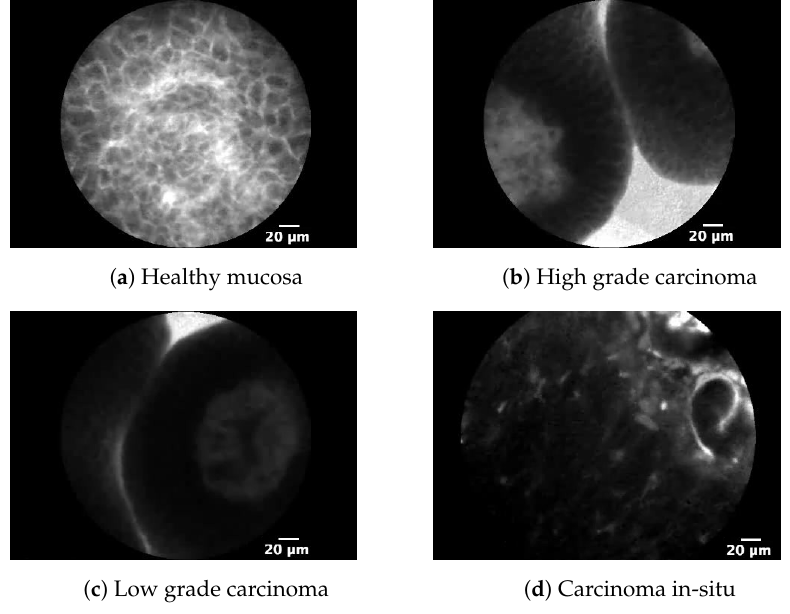
Figure 2. Representation of all four cystoscopy dataset